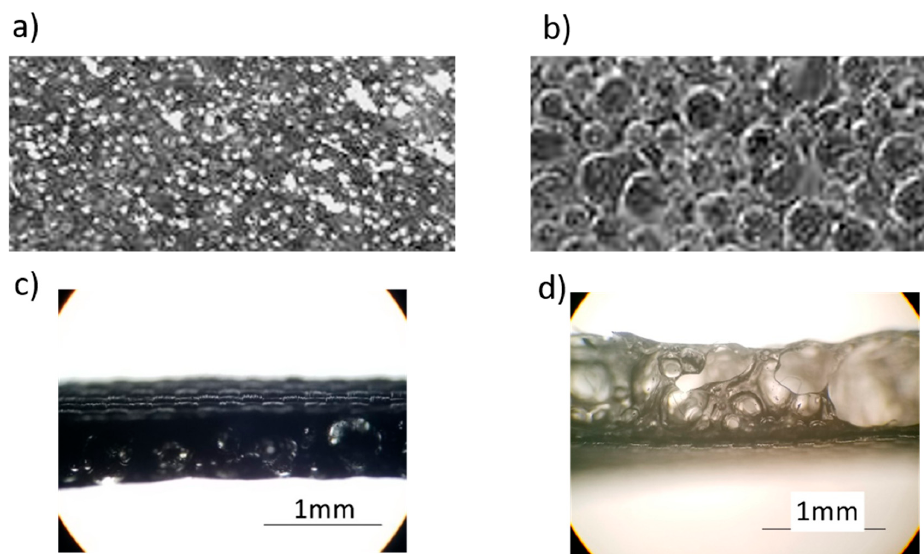
Figure 3. ( a ) Top surface of a carbon nanotube (CNT)-doped porous PDMS sample; ( b ) top surface of undoped porous PDMS sample; ( c ) cross sections of CNT-doped porous PDMS sample; ( d ) cross sections of undoped porous PDMS sample.